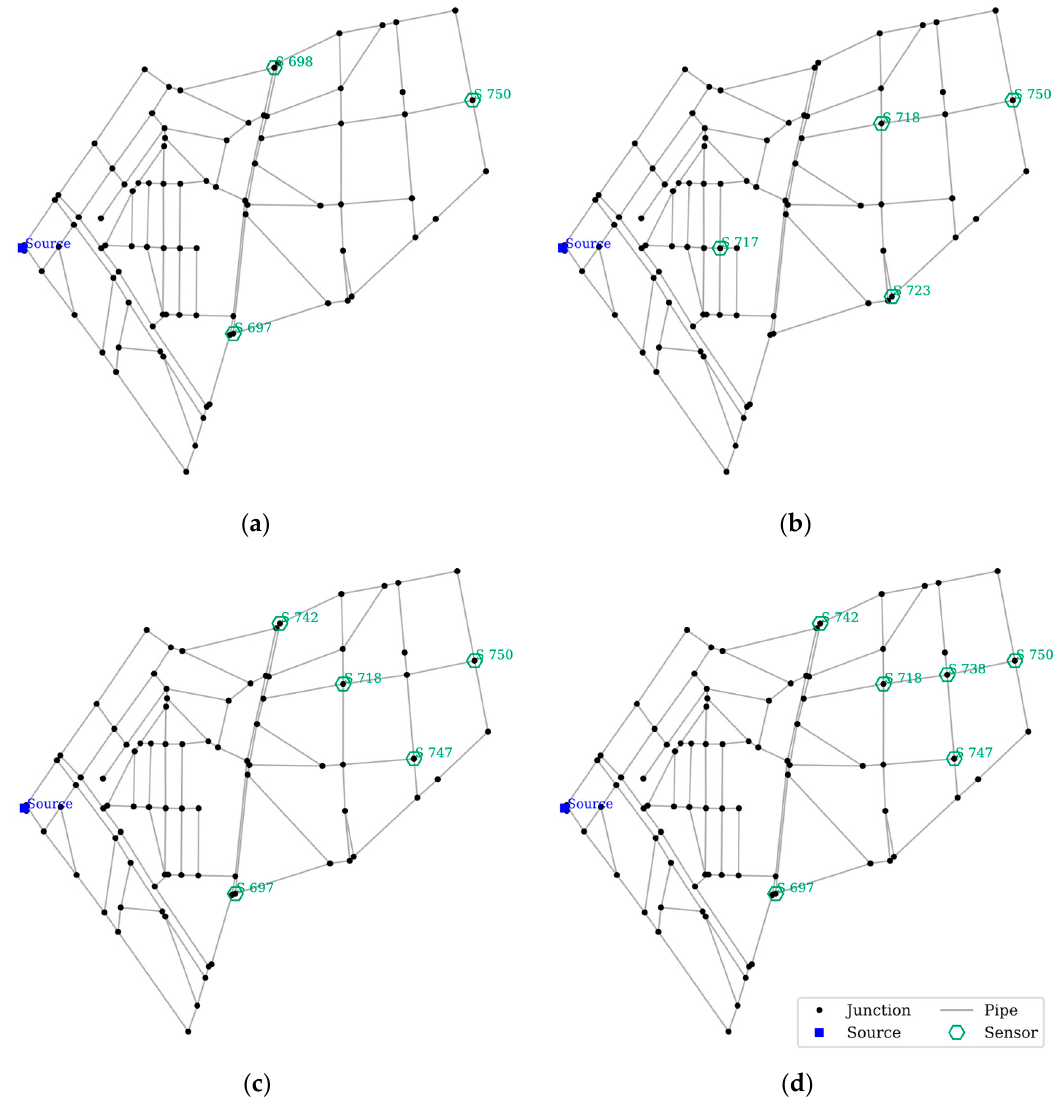
Figure 9. Sensor configuration for NET-B ( a ) Config-A, ( b ) Config-B, ( c ) Config-C, and ( d ) Config-D. Table 5. Performance comparison for NET-B.